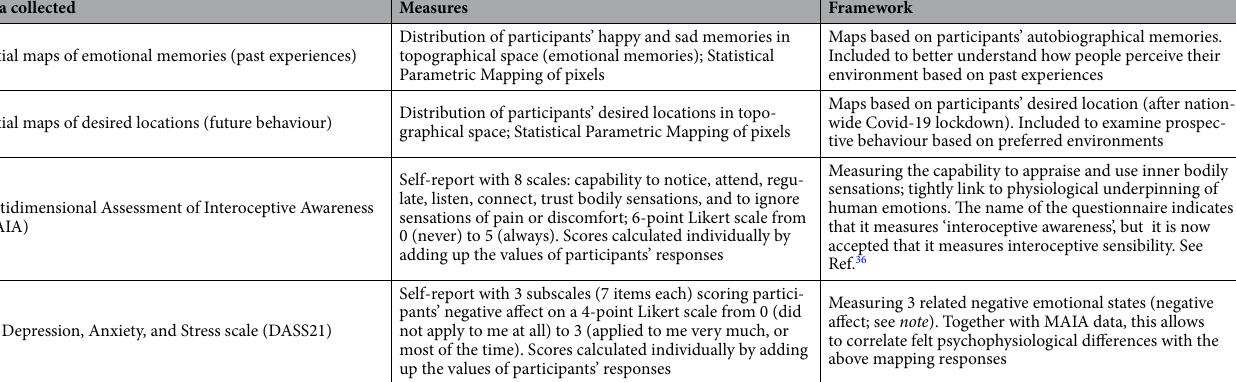
Table 1. Summary of data collected, measures, and framework. Significant clusters in the maps were revealed when participants reported similar emotional memories, in similar regions, and in a similar manner (happy or sad); Participants’ maps were also correlated with their scores in the MAIA and DASS21, revealing locations distinctively recalled as function of participants’ felt psychophysiological differences; Spatial maps of emotional memories and desired locations were also contrasted with an objective map of natural and non-natural environments, allowing to test the overlapping of the mapping response in one vs. the other environment; The term ‘affect’ is used in the manuscript to refer to the scores of the DASS21, which is intended to measure negative affect 17,18